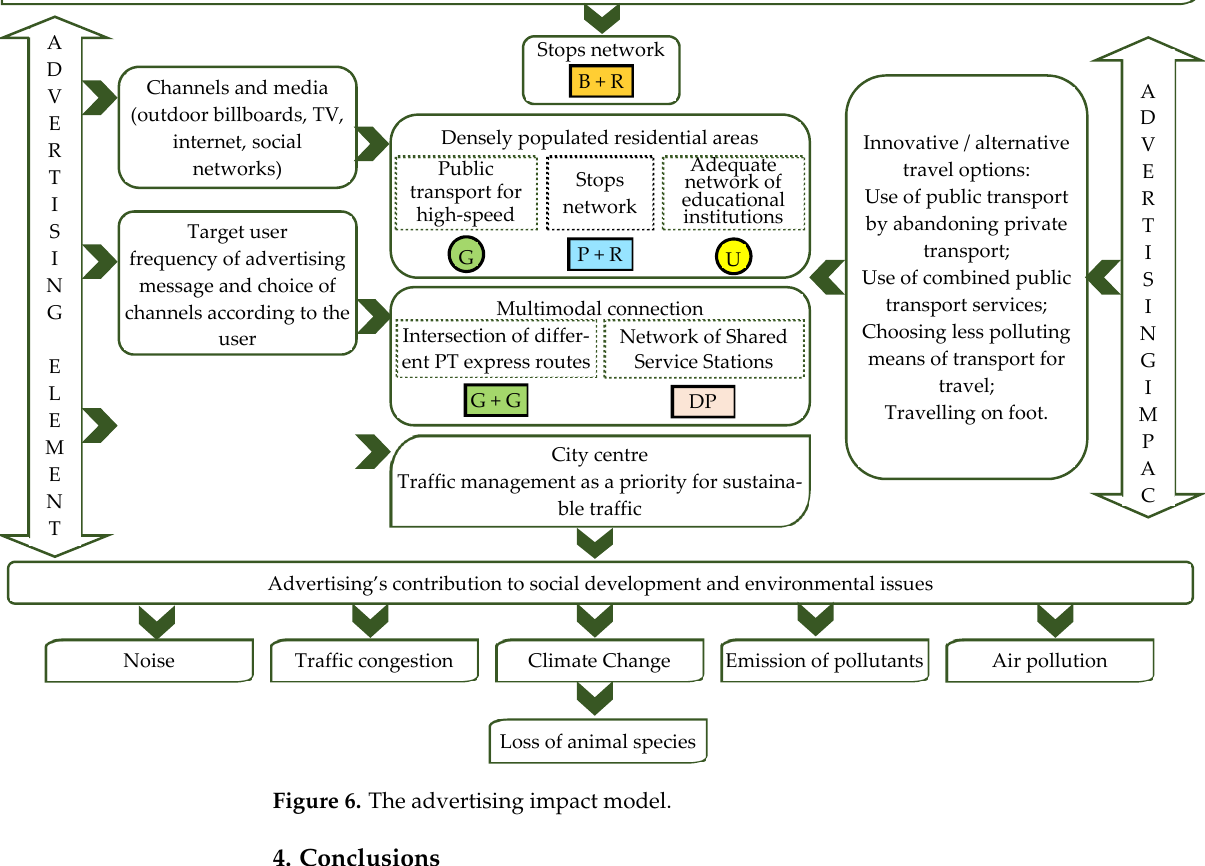
Figure 6. The advertising impact model.